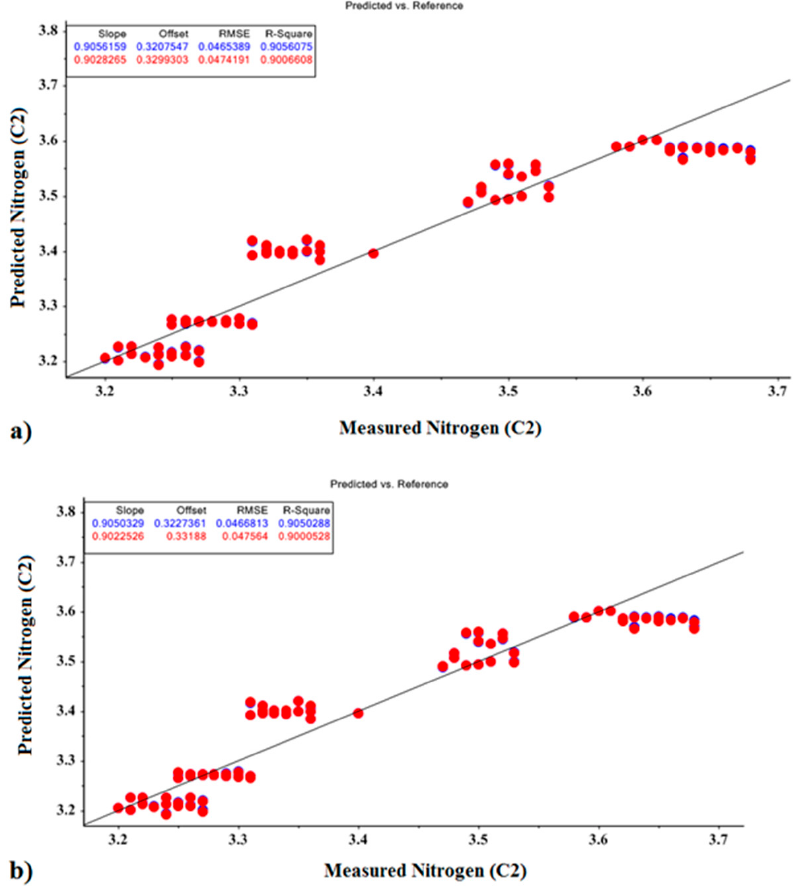
Figure 7. MLR prediction models for nitrogen fertilizer based on optimal factors of ( a ) PCR model and ( b ) PLSR model.